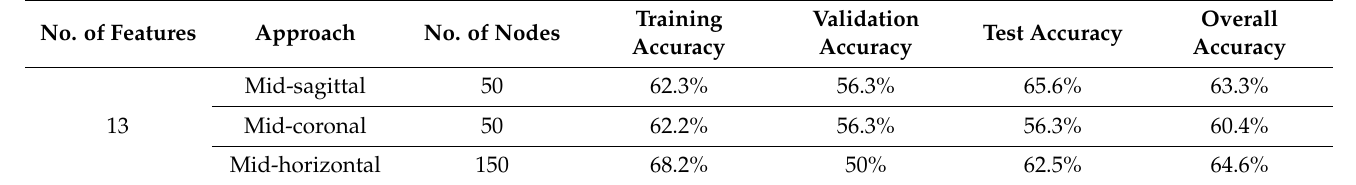
Table 7. Performance of the best OST prediction systems, with volumetric and location features with age and resection status factors, using